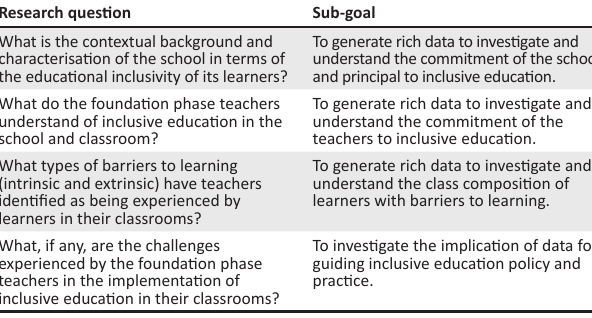
TABLE 1: Summary of research questions and